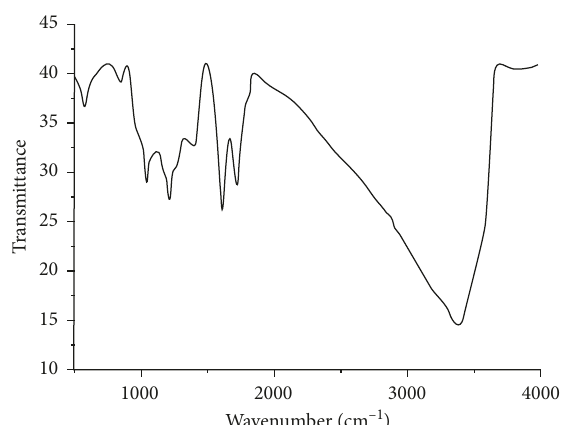
Figure 3: FT-IR spectrum of as-prepared